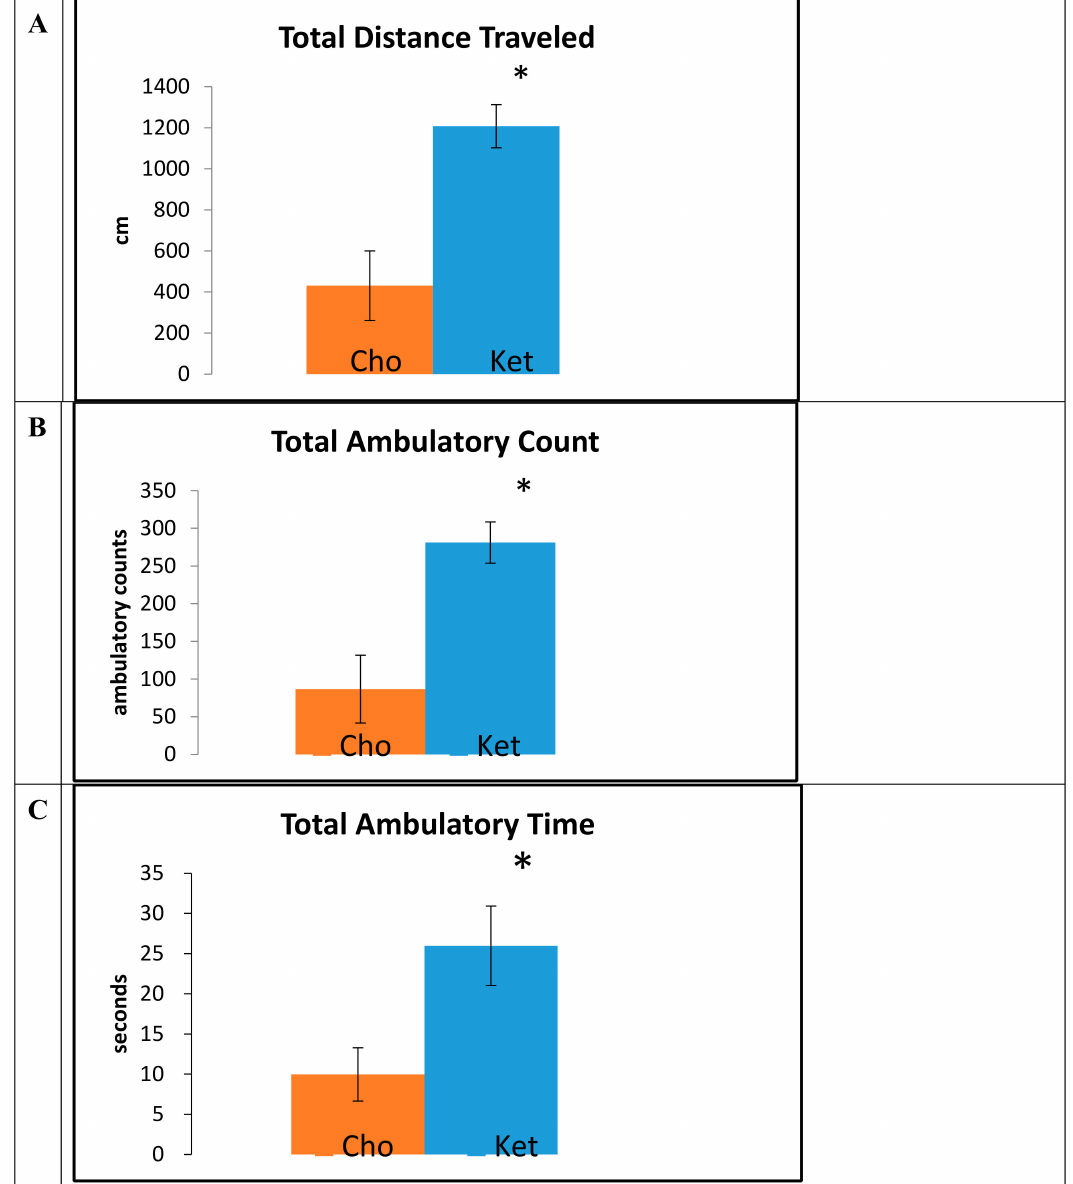
Figure 2. Open field assessments for 3xTgAd mice fed either a control diet (n = 7, Cho) or ketone ester diet (n = 7 or 8, Ket) for 8 months, measured at 15 months of age. ( A ) Total distance traveled, ( B ) total ambulatory counts, and ( C ) total ambulatory